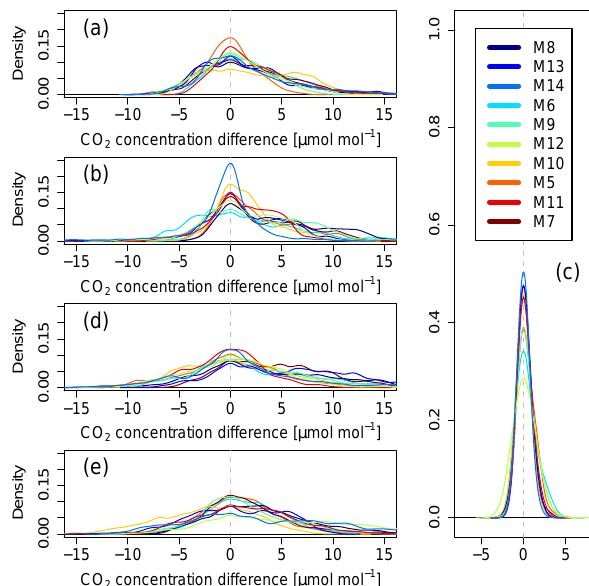
Fig. 8. Density distribution of concentration differences c i ( t ) − ˜ c ( t ) using bias corrected measured 60-minute concentration timeseries c i ( t ) , number of sample locations n = 10 , for five typical cases over the course of the day on 29 June 2008 with varying stability parameter ζ (measured at a 36m height) and mixing index MI (ac- cording to Eq.3), night time, 01:00-02:00, ζ = − 0 . 16 , MI =0.015 (a) , night-day transition, 07:00-08:00, ζ =0 . 65 , MI =0.020 (b) , day- time, 12:00-13:00, ζ = − 0 . 27 , MI =0.218 (c) , day-night transition, 19:00-20:00, ζ = 0 . 06 , MI =0.010 (d) and nightime with katabatic drainage flow, 22:00-23:00, ζ = 19 . 50 , MI =0.016 (e) . Legend indi- cates measurement locations according to Fig.1. Fig. 9. Time series of the mode s of density distributions of con-